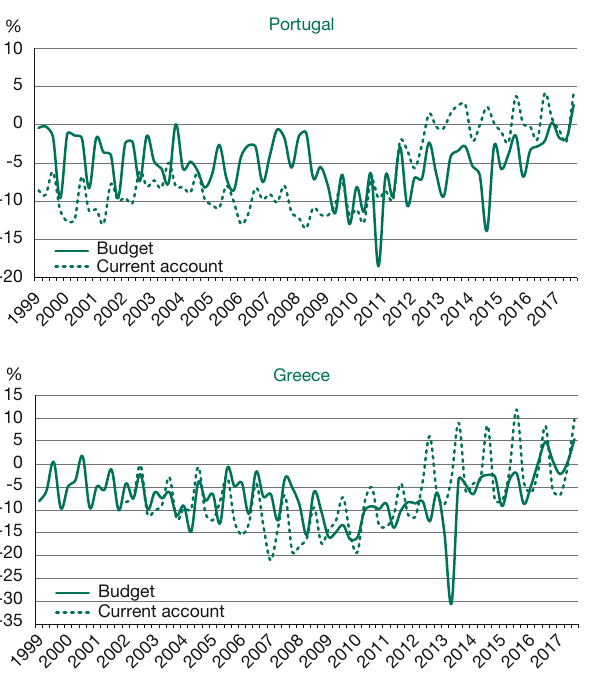
Current account defi cit and budget defi cit as percentage of GDP in selected